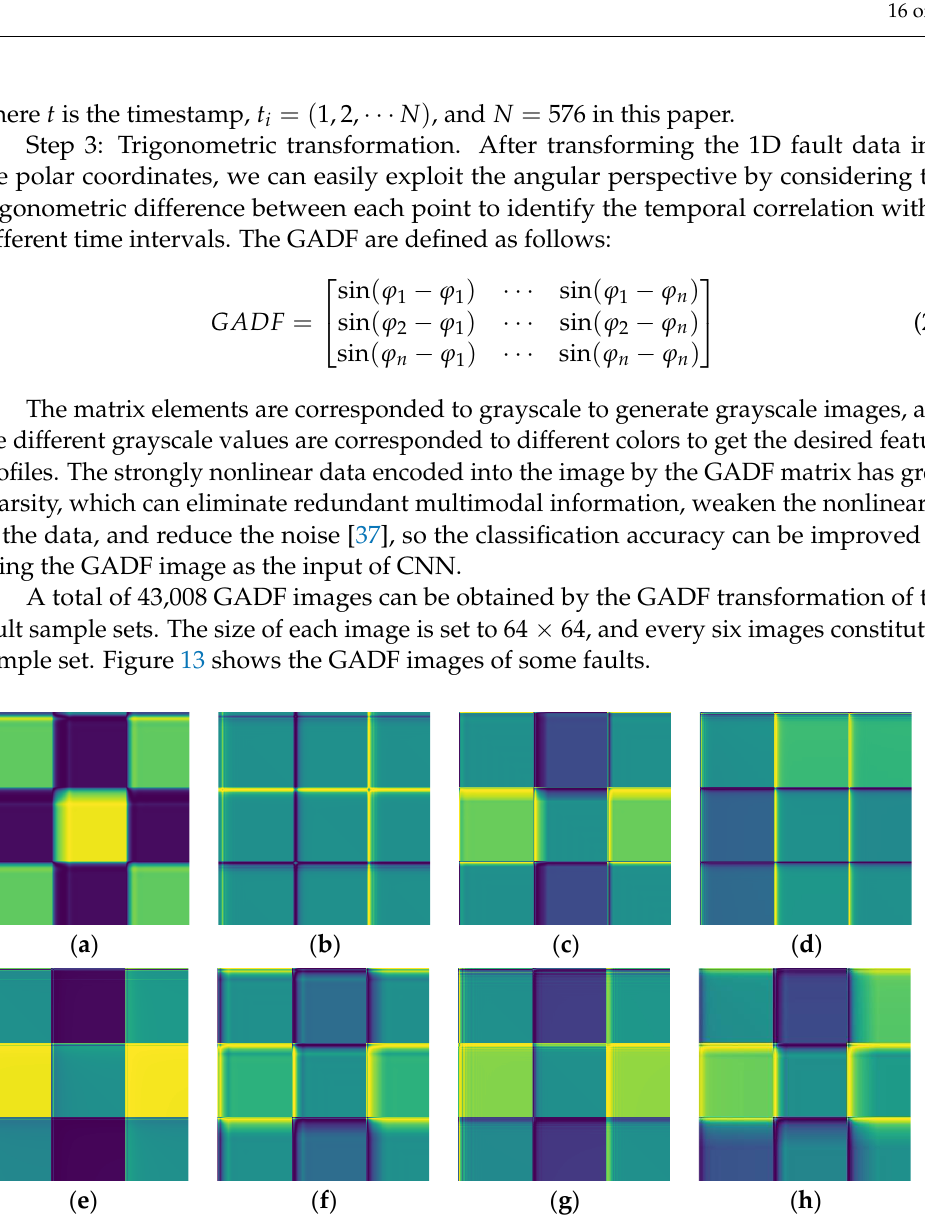
Figure 13. GADF images: ( a ) Internal leakage of hydraulic pumps (displacement of actuator); ( b ) Oil mingled with air (velocity of actuator); ( c ) Internal leakage of actuator (rotation speed of motor); ( d ) Friction increases (pressure difference of pump); ( e ) Loss of sensor gain (flow of plunger pump); ( f ) Oil mingled with air (rotation speed of motor); ( g ) Friction increases (outlet pressure of accumulator); ( h ) Internal leakage of hydraulic pumps (pressure difference of pump).